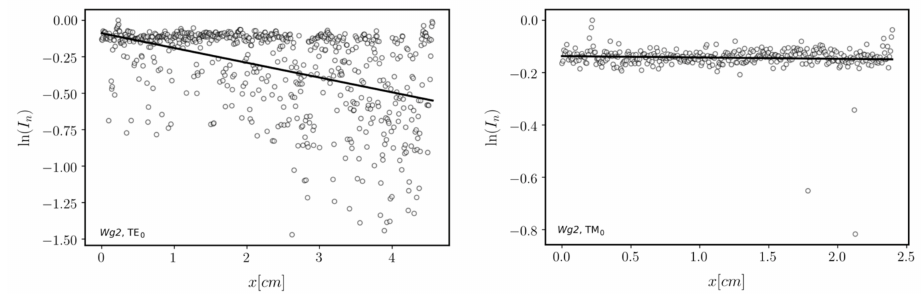
Figure 10. The linearized distribution of normalized light intensity for linear scans selected from light streaks is presented in Figure 8 (Wg2).